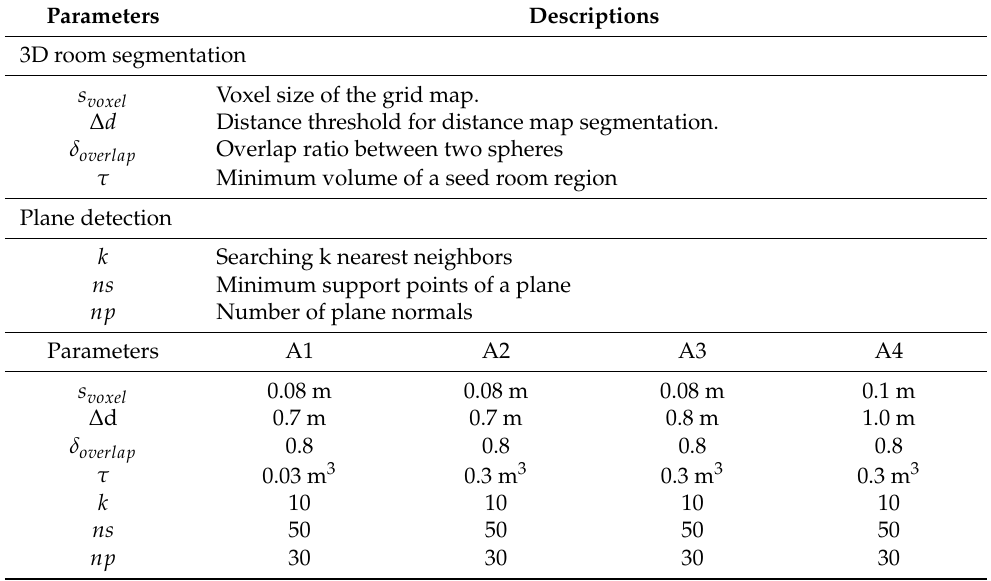
Table 3. Input parameters for the point cloud